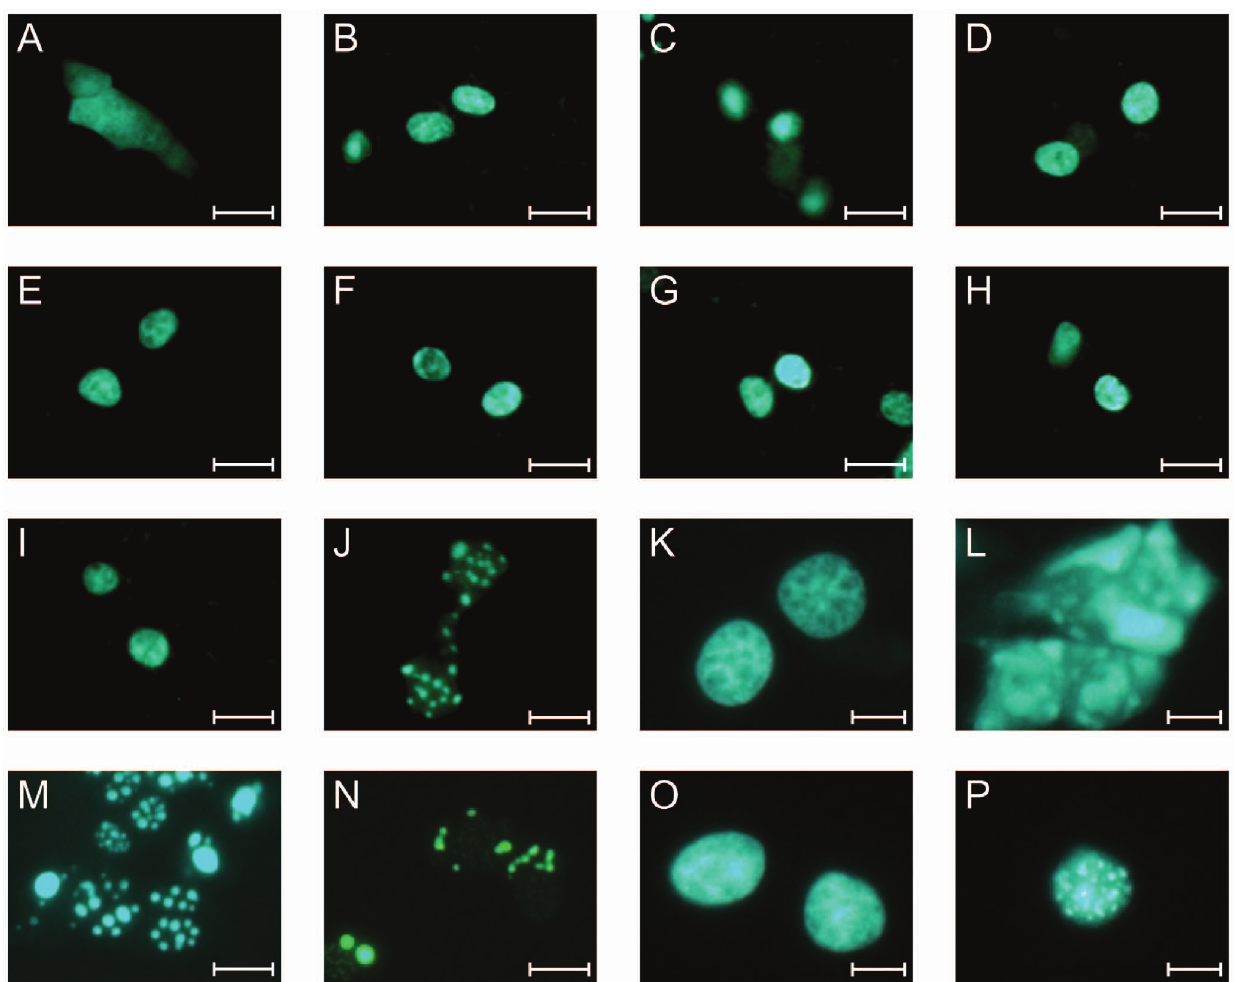
Figure 3. Cellular expression of the fusion proteins between GFP and HMX1 and its mutants in HEK 293T cells. GFP is expressed in the whole cell (A), whereas GFP-HMX1 is expressed in the nucleus (B). The different mutants, GFP-HMX1 del SD1 (C), GFP-HMX1 del SD2 (D), GFP-HMX1 del Cter1 (E), GFP-HMX1 del Cter2 (F), GFP-HMX1 del Cter3 (G), GFP-HMX1 del Cter4 (H) and GFP-HMX1 del Cter5 (I) retain a nuclear localization. GFP- HMX1 del HD on the other hand is expressed in a punctate manner (J). These aggregates are present in the nucleus as well as in the cytoplasm: compare L (GFP-HMX1 del HD before nuclei isolation) and P (GFP-HMX1 del HD after nuclei isolation) to K (GFP-HMX1 before nuclei isolation) and O (GFP-HMX1 after nuclei isolation). Reinsertion of the seven-amino acid KKTRTVF did not change the punctate phenotype (M), nor did the deletion of the Cter half of the homeobox (N). Scale bars: 50 m m for A-J, M, N; 10 m m for K, L, O, P.